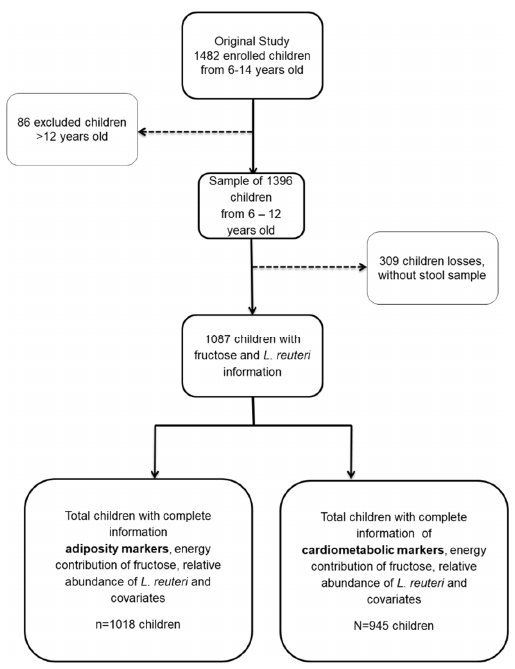
Figure 1. Children from México City study sample.